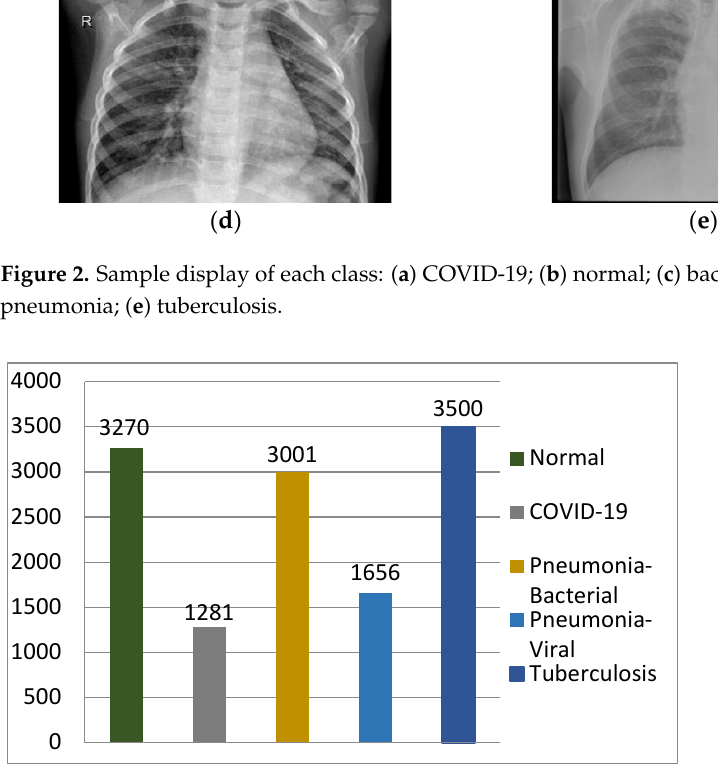
Figure 3. Sample distribution of class data.